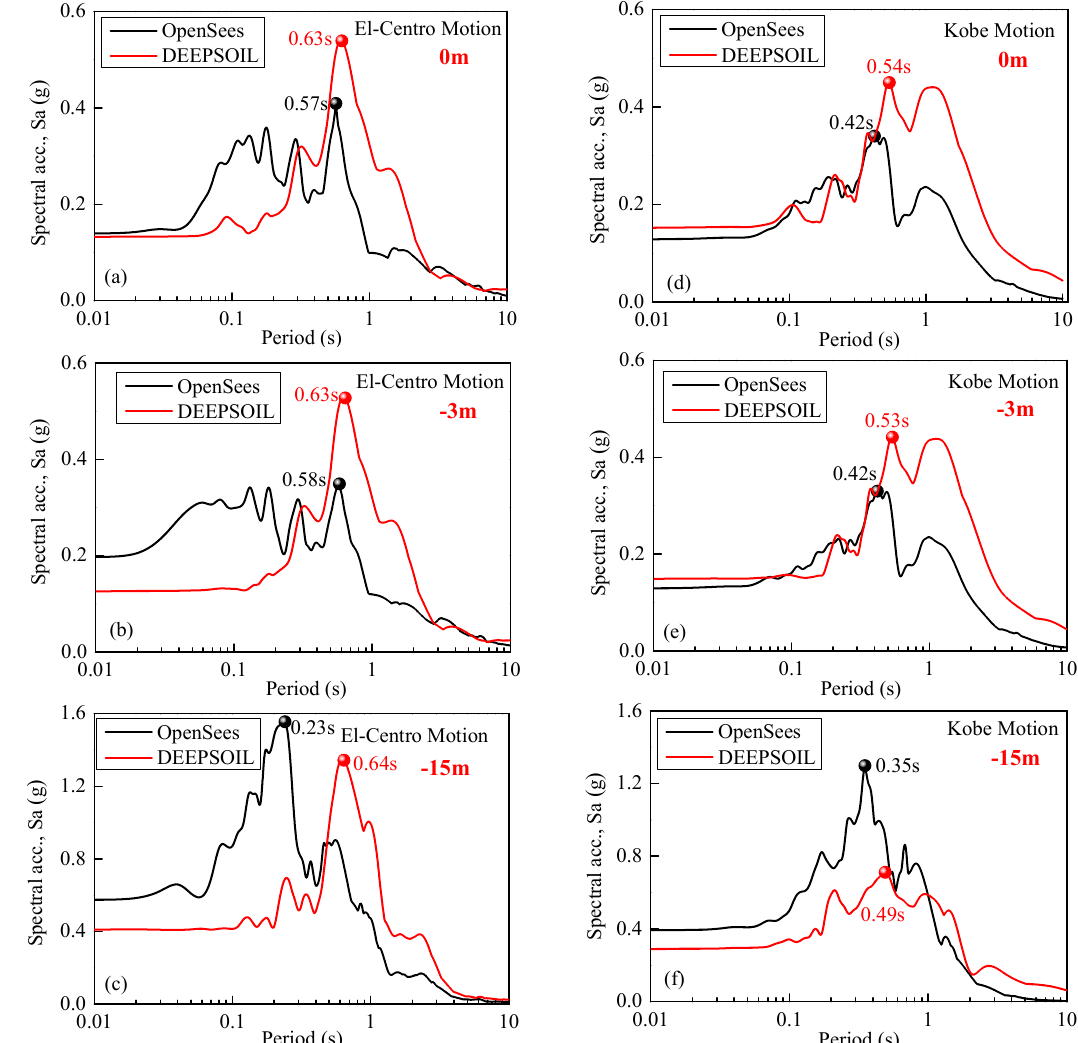
Figure 16. Acceleration response spectra with 5% damping ratio: ( a ) 0 m; ( b ) −3 m; ( c ) −15 m under the El-Centro motion and ( d ) 0 m; ( e ) −3 m; ( f ) −15 m under the Kobe motion.